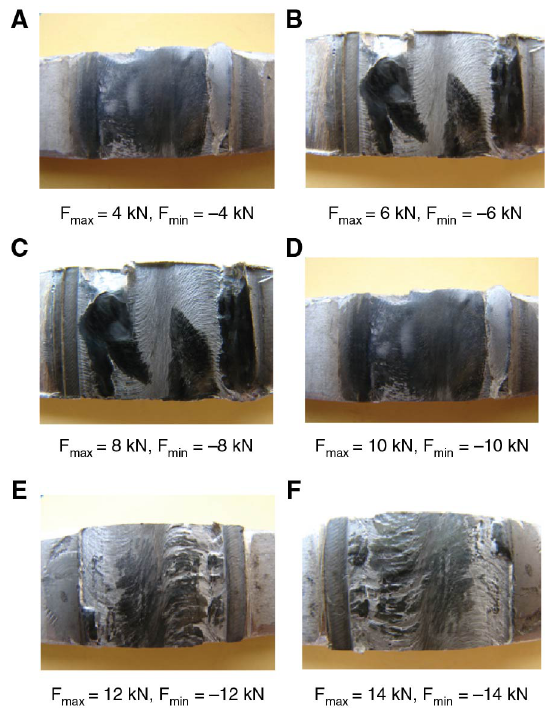
Figure 12: Photographs of failed T-joint specimen at R = − 1. The fracture surface for R = − 1 is very different than R = 0 as shown in Figure 12. A clear polished surface is seen for R = − 1 which is due to repeated compressive load applied during the fatigue testing. The quality and the magnitude of polished surfaces are higher where the applied load level is low. At load level F > ±10 kN, failure surfaces are different than F < ±10 kN. This may be due to fact that at higher load level, i.e. F > ±10 kN, the crack initiation and propagation time is less as compared to F < ±10 kN and sudden fracture occurred leaving a very clear rough